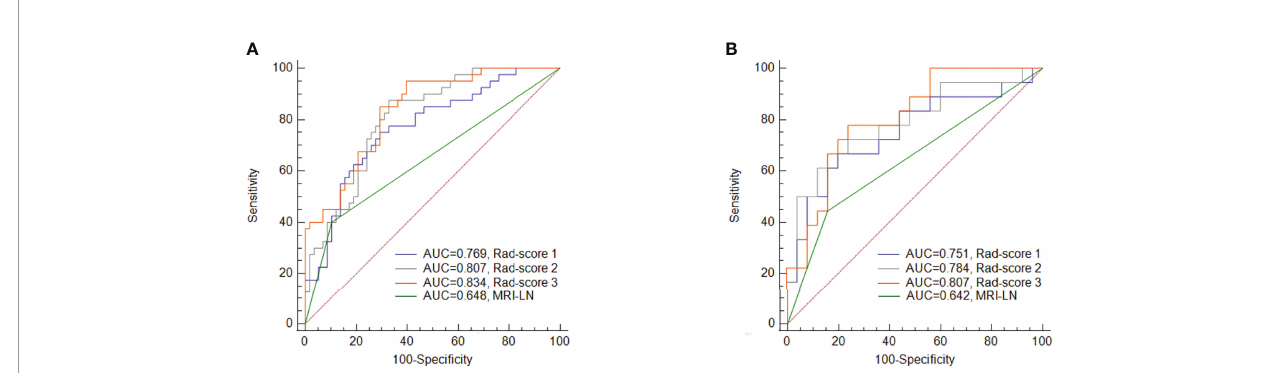
FIGURE 3 | Comparisons of the ROC curves for MRI-reported LN status and the three rad-scores in the training cohort (A) and validation cohort (B) . MRI-LN, MRI- reported LN status.